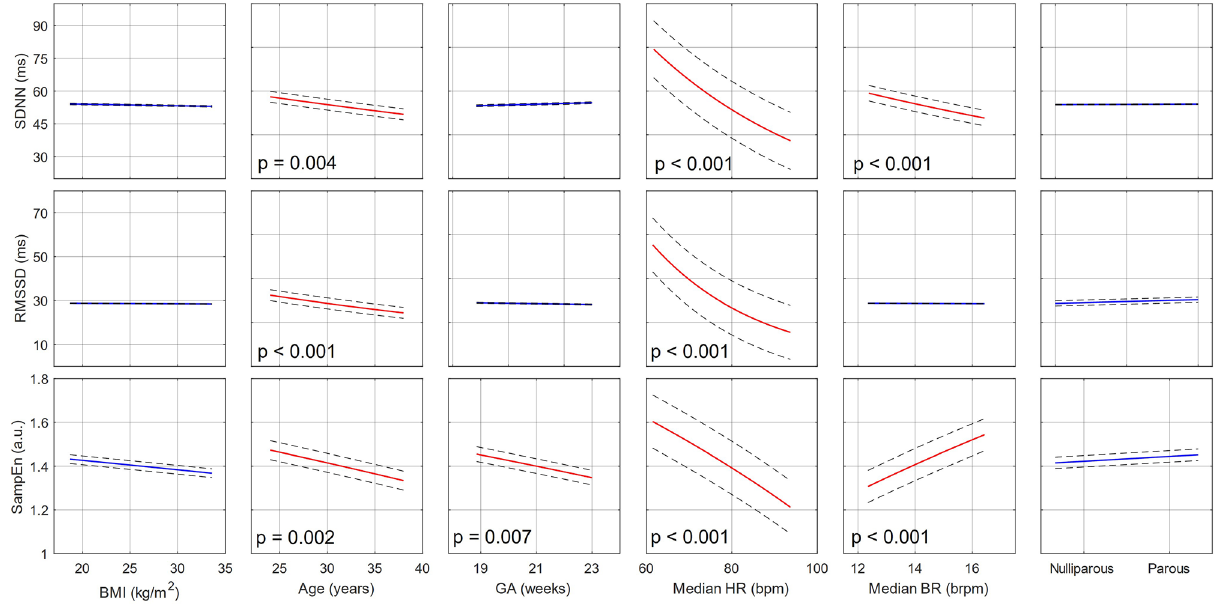
Figure 1. Individual regression plots showing the relationship between individual IVs (from left to right: BMI, Age, GA, Median HR, Median BR, and parity) and the three DVs (from top to bottom: SDNN, RMSSD, and SampEn) of the MLR developed for Dataset